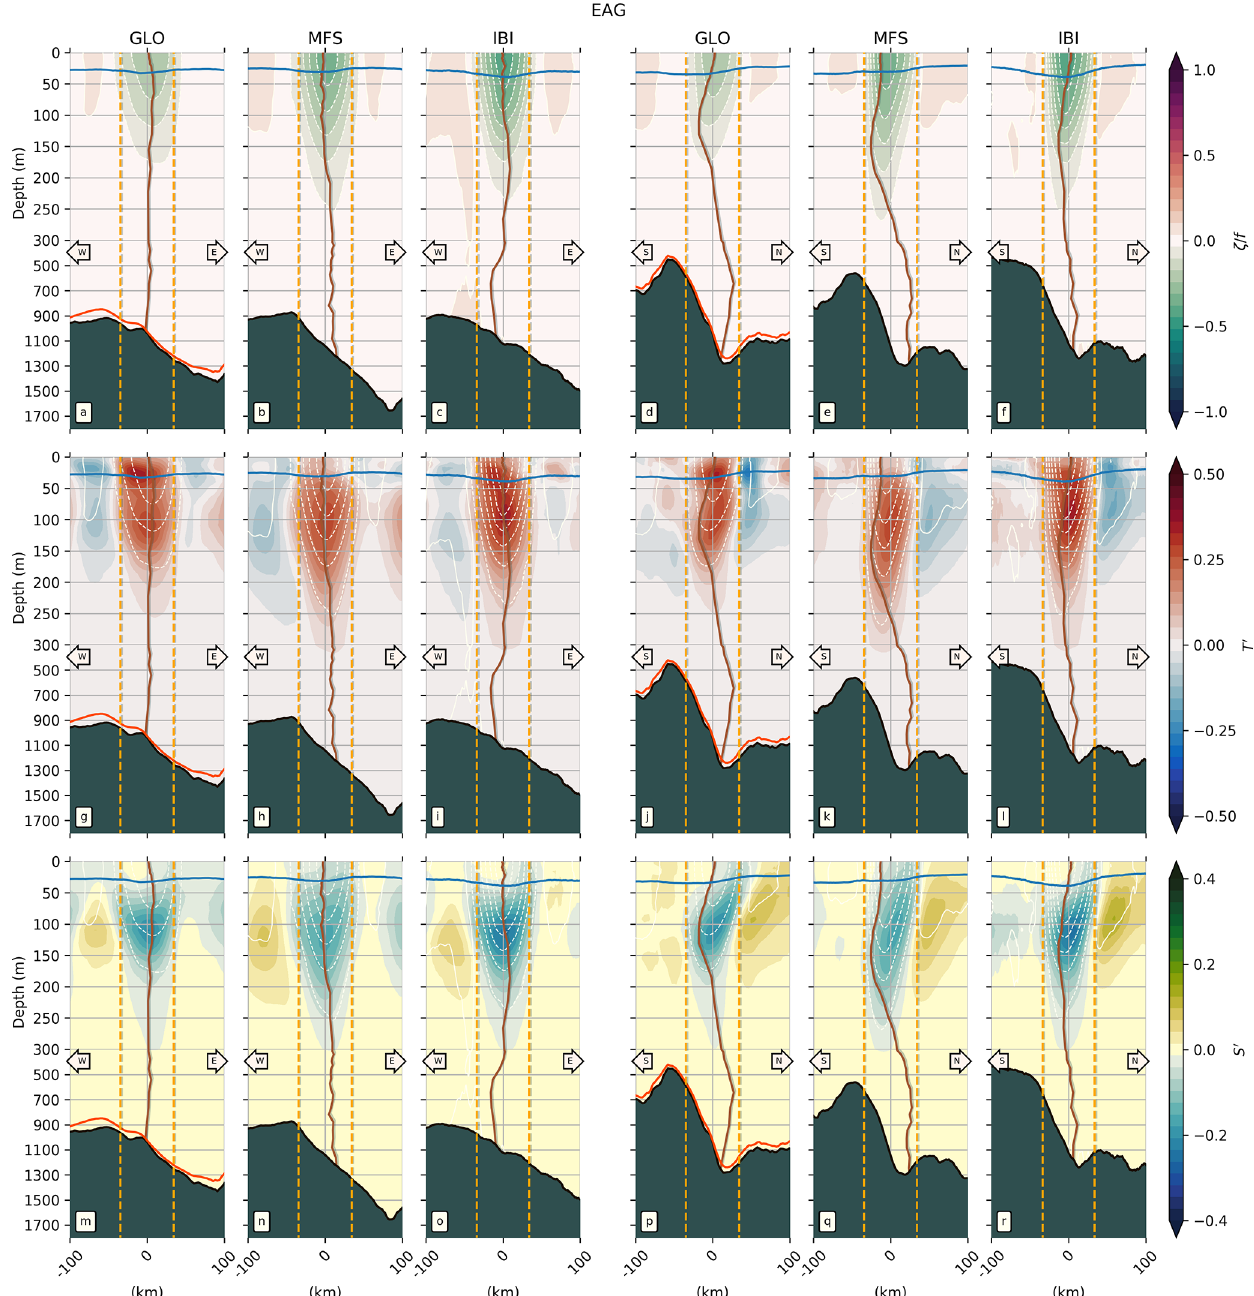
Figure 8. Same as Fig. 7 but for the Eastern Alboran